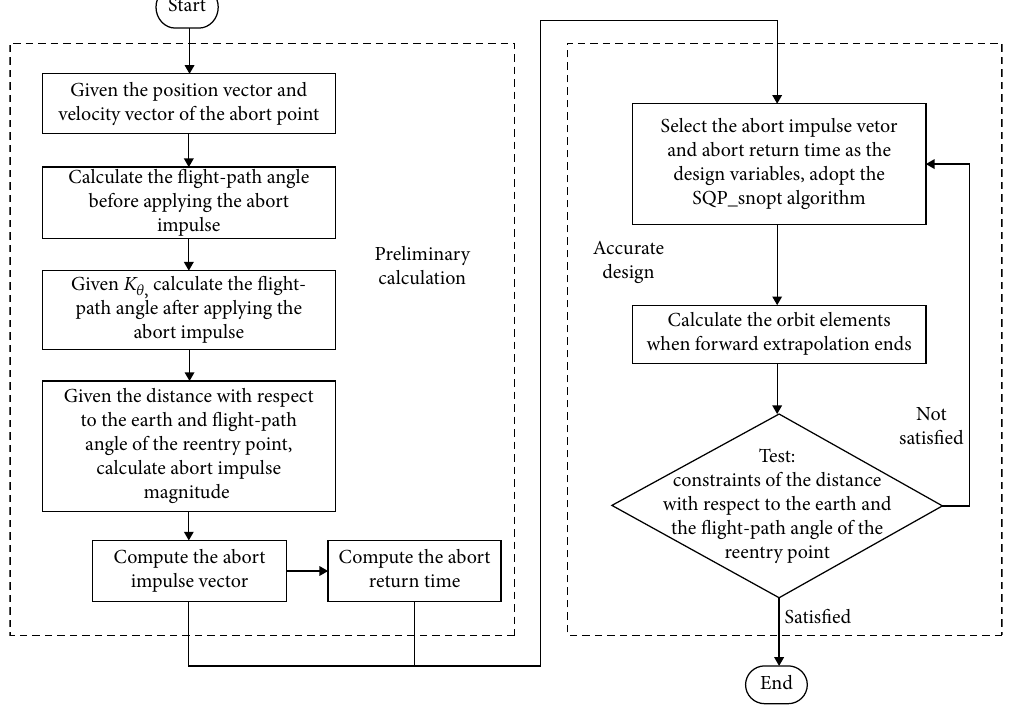
Figure 2: Flow chart of the single-impulse abort orbit design method.